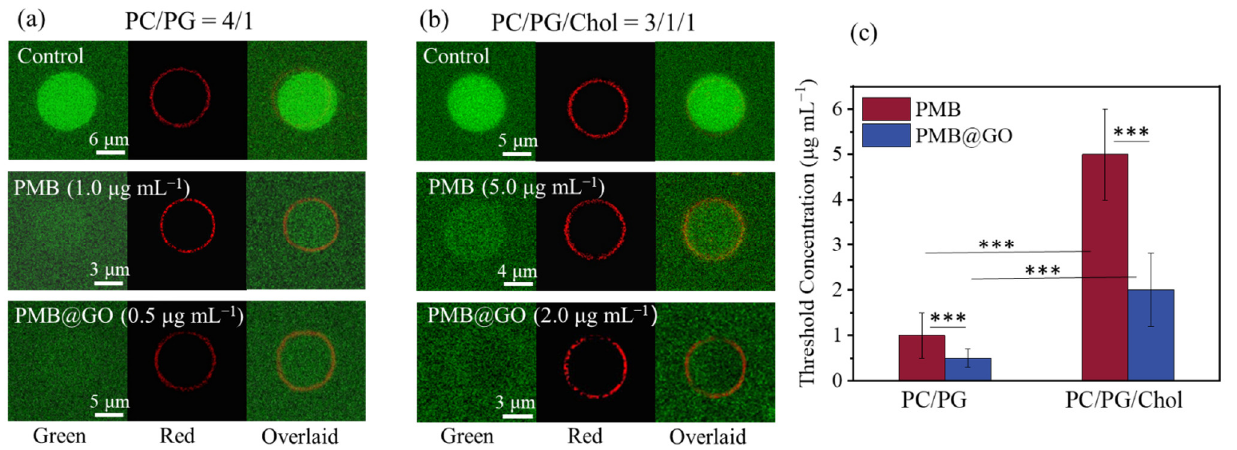
Figure 4. Membrane permeabilization test of free PMB and PMB@GO over different model mem- branes. ( a ) Representative confocal images of calcein-encapsulated GUVs (composed of PC and PG, with PC:PG = 4:1 by mol) after 30 min of incubation with no drug, PMB (at 1.0 µ g mL − 1 ), or PMB@GO (at 0.5 µ g mL − 1 with respect to peptide). ( b ) Representative confocal images of calcein-encapsulated GUVs (composed of PC, PG, and Chol, with PC:PG:Chol = 3:1:1 by mol) after 30 min incubation with no drug, PMB (5.0 µ g mL − 1 ), or PMB@GO (2.0 µ g mL − 1 ). ( c ) Histograms showing the threshold agent concentration for calcein leakage. Images in ( a , b ) were taken in the green (calcein), red (RhB-PE), and merged channels. The data in ( c ) show the normalized mean and standard error of five independent experiments. p -values were calculated by ANOVA (*** p < 0.001).